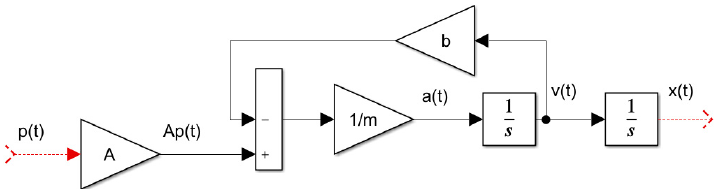
Figure 12. Continuation of the block diagram of the hydraulic part of the hydraulic motor based on the modified Equation (6), with the red lines being I/O signals in this part of the block diagram.